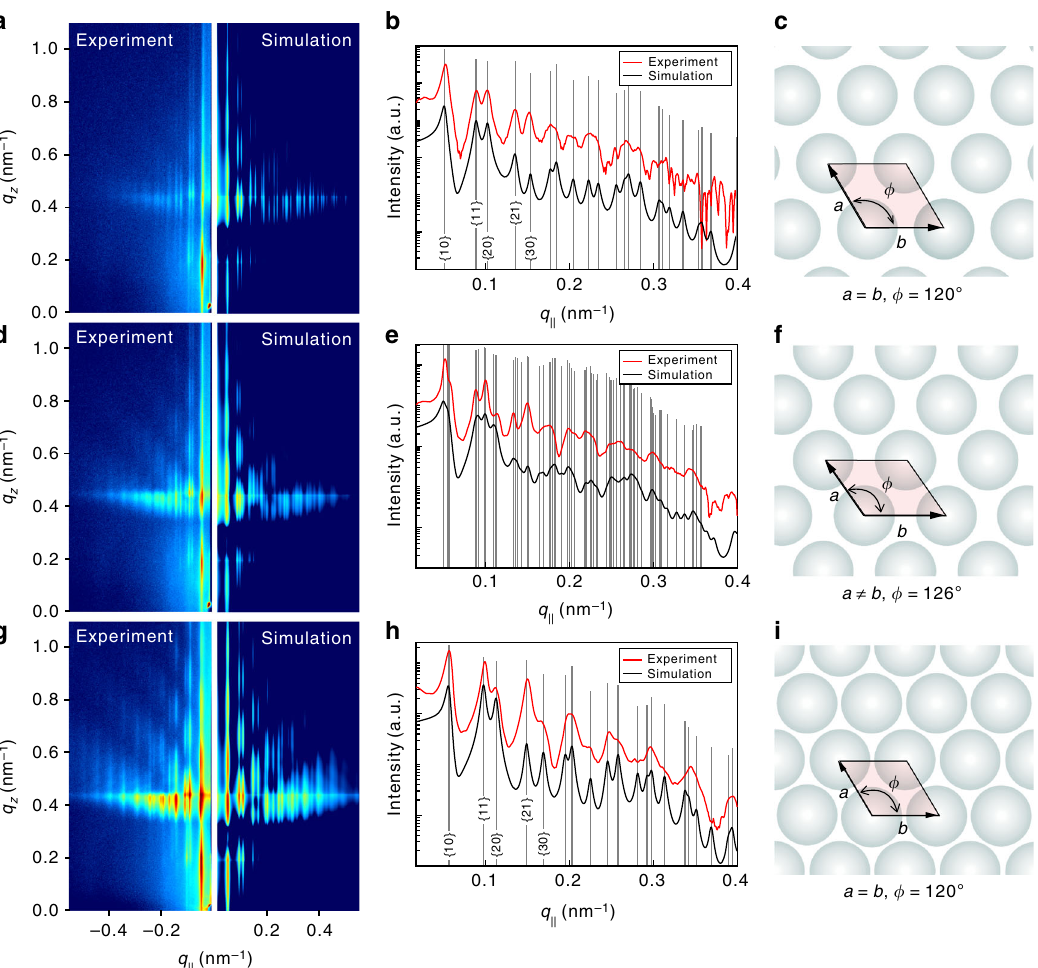
Fig. 3 GISAXS data analyses and in-plane superlattice structures. a , d , g Experimental GISAXS patterns (left) compared with their corresponding simulated patterns (right). The GISAXS data are recorded at the surface pressures of 0.2, 10.4, and 17.6 mN m − 1 and the corresponding areas per particle of 2.82 × 10 − 2 , 2.30 × 10 − 2 , and 2.13 × 10 − 2 μ m 2 , respectively, (marked as diamonds in Fig. 1c). b , e , h The experimental (red solid lines) and simulated (black solid lines) 1D scattering pro fi les are extracted from the corresponding GISAXS patterns (i.e ., a , d , g ), along the q ∥ direction around q z = 0.434 nm − 1 (the Yoneda peak of water). Each gray line identi fi es a Bragg diffraction peak. c , f , i Schematic diagrams of the superlattice structures obtained from